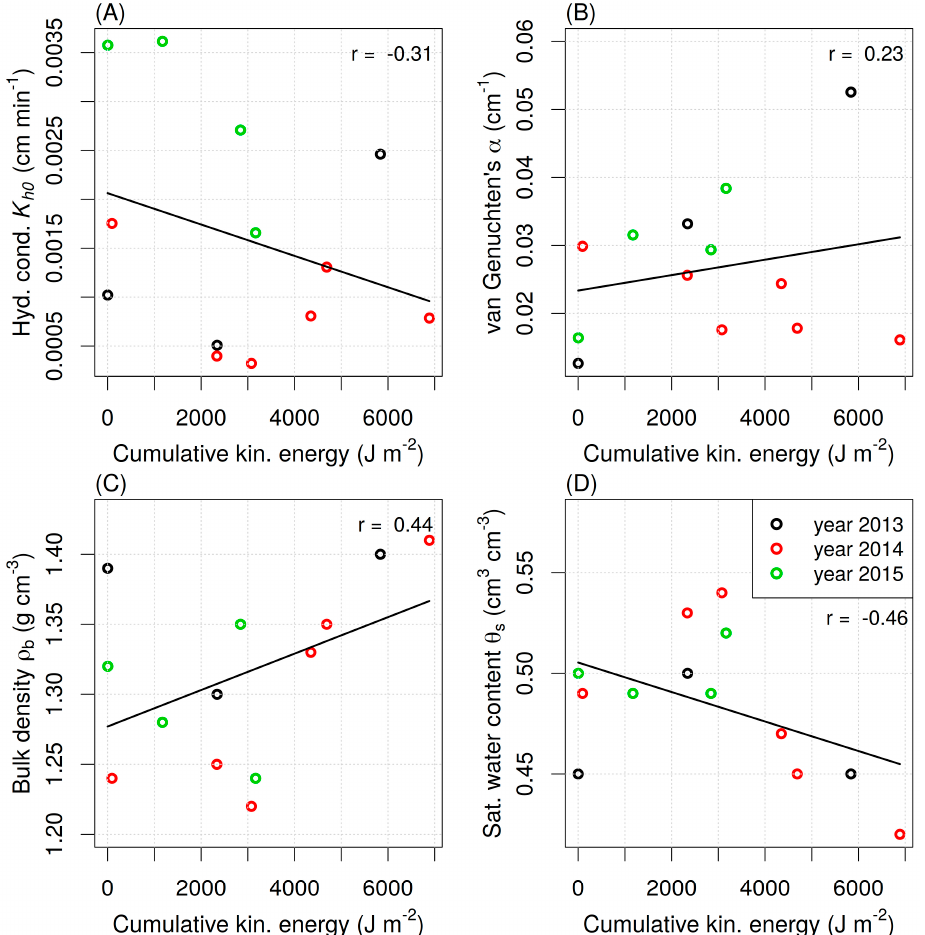
Figure 11. Correlation between cumulative rainfall kinetic energy and unsaturated hydraulic conductivity K h 0 ( A ), van Genuchten’s parameter α ( B ), bulk density ρ b ( C ) and saturated water content θ s ( D ). The correlation coefficient r is calculated based on all data points in each graph. The color, which distinguishes data from different years, only serves for visual interpretation of the data.